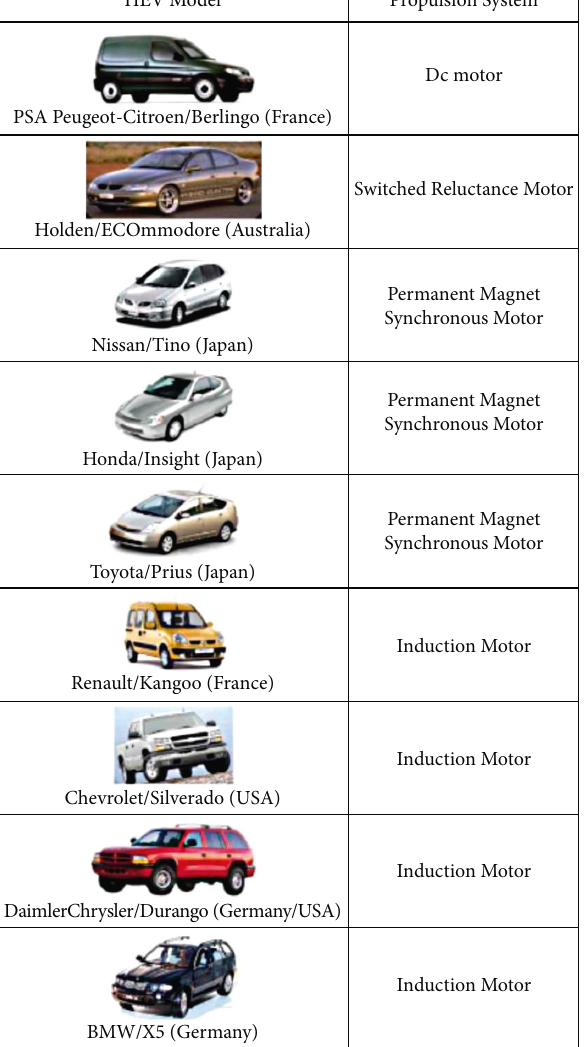
Figure 8: Various motors implemented in various